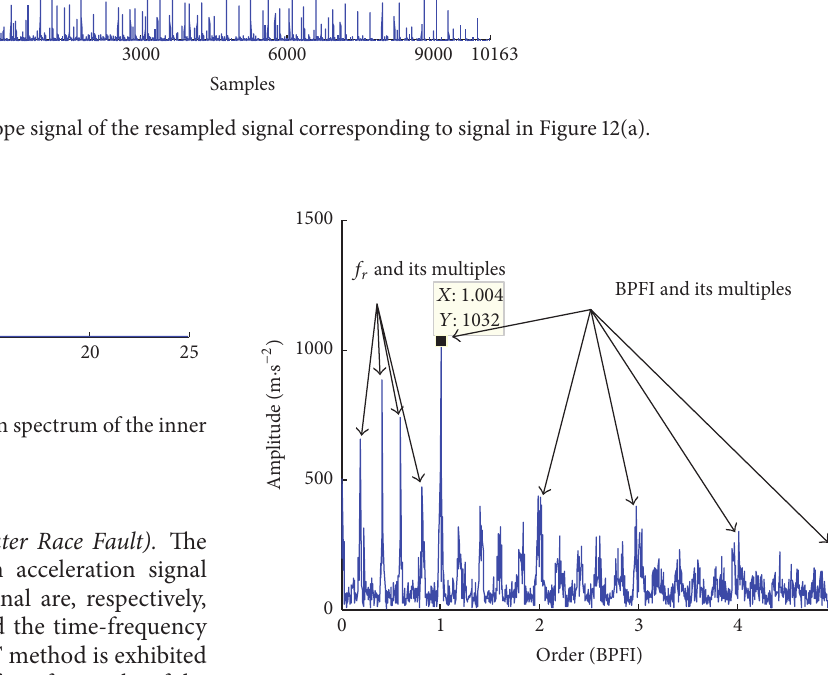
Figure 17: The detail display of Figure 16 by reducing the order-axis display range to [0,5 BPFI ]